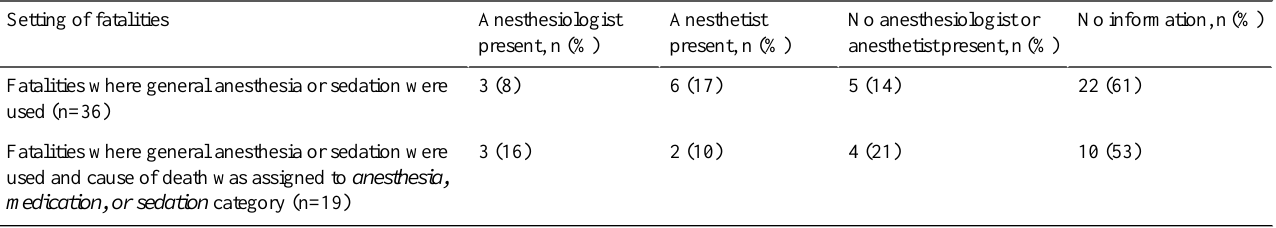
Table 4. Fatalities in dental practices with general anesthesia and sedation with respect to the presence of an anesthesiologist or anesthetist, based on data from PubMed